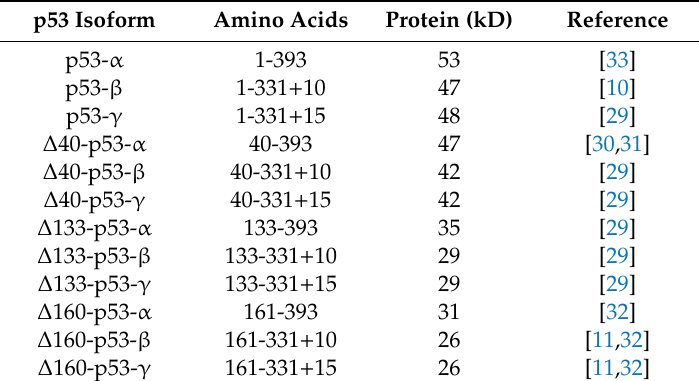
Table 1. p53 isoform